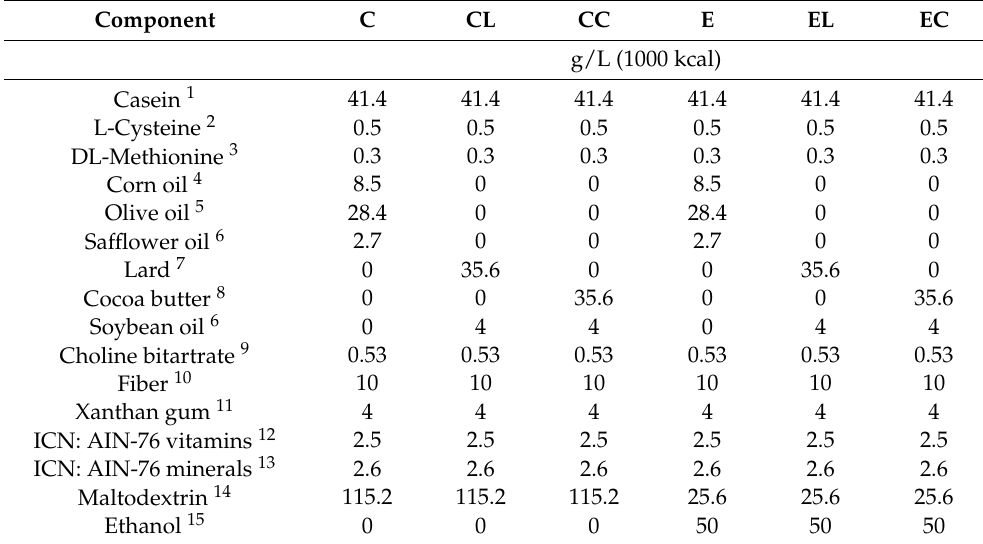
Table 1. Composition of the experimental liquid diets.